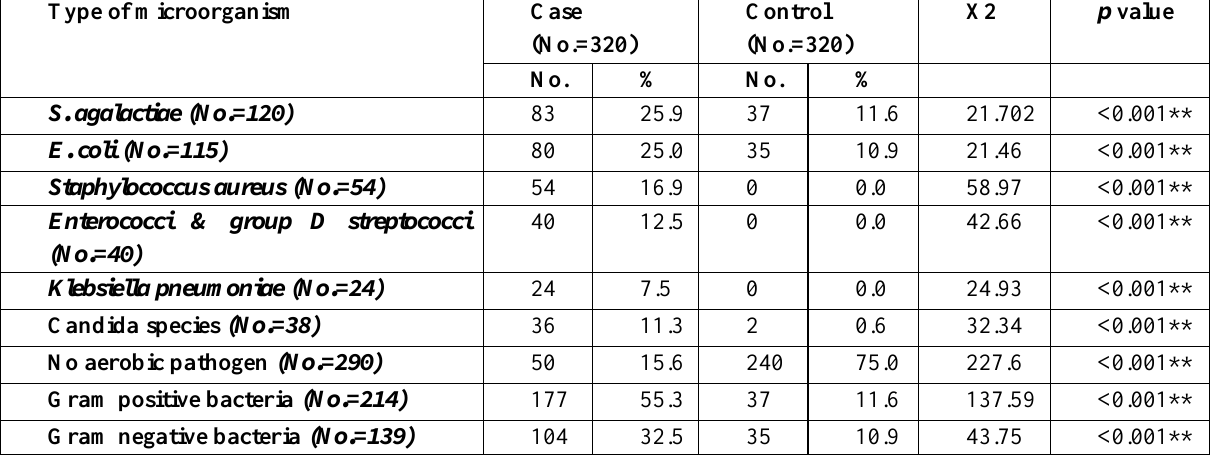
Table 3. Revealed significant microbial growth in culture of vaginal swab in case and control groups.